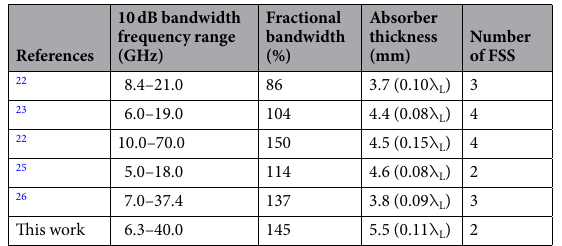
Table 1. Summary of the important results of existing works on the broad bandwidth absorbers of multilayer FSS structures. The fractional bandwidth is given by the ratio of bandwidth to center frequency. λ L is the wavelength at the lowest operating